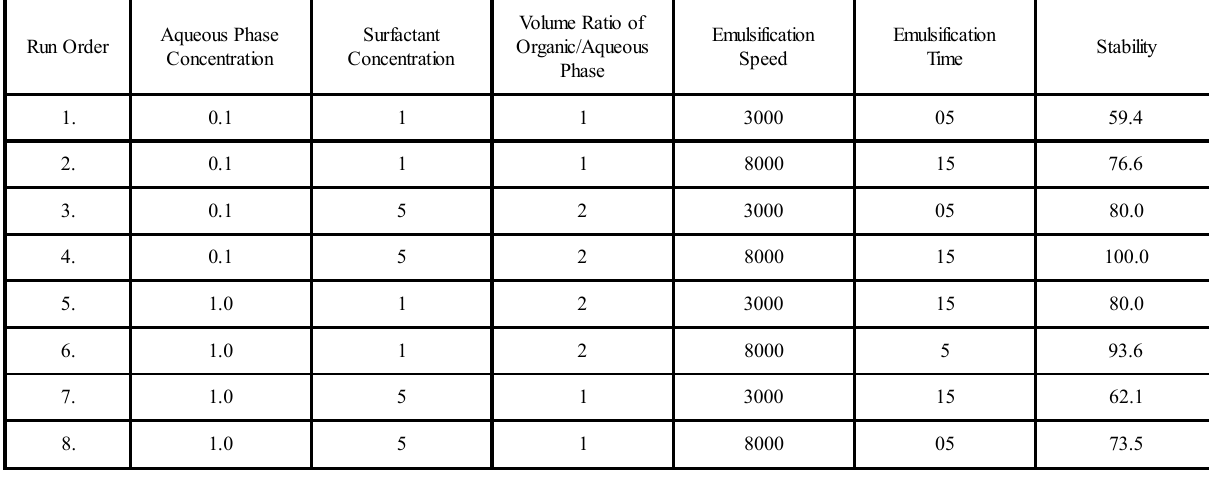
TABLE 2. EXPERIMENTAL RESULTS ACCORDING TO SCREENING